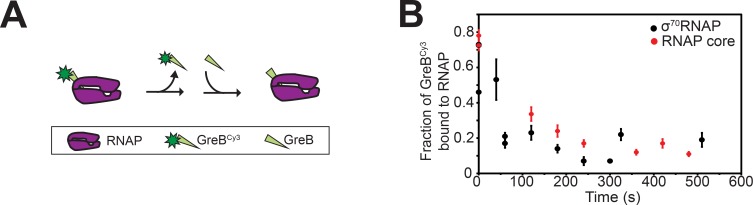
Kinetics of GreB dissociation from RNAP and σ70RNAP.(A) Experimental scheme for observing dissociation of GreBCy3-RNAP complexes by FCS. (B) GreBCy3 remaining bound (±SE) to σ70RNAP (black) or RNAP (red) at different times after the addition of 100-fold excess unlabeled GreB, calculated from fits to FCS autocorrelation curves.